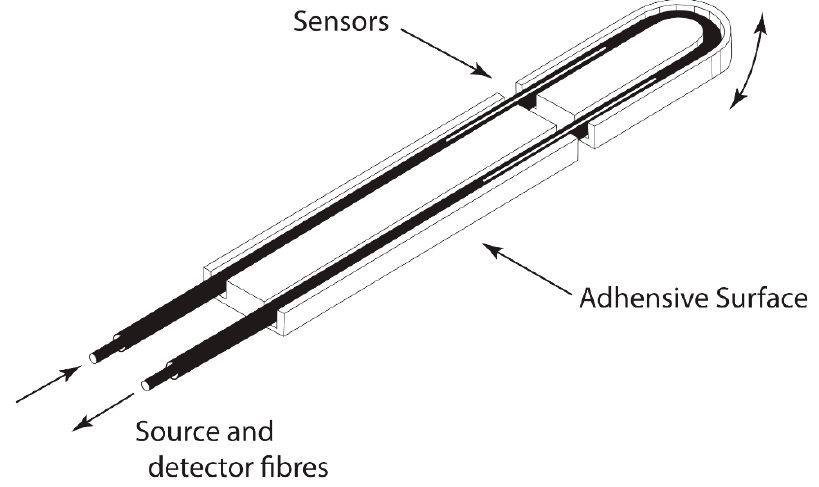
Figure 1. Illustration of optical respiratory sensor (the sensor is approximately 8 cm in